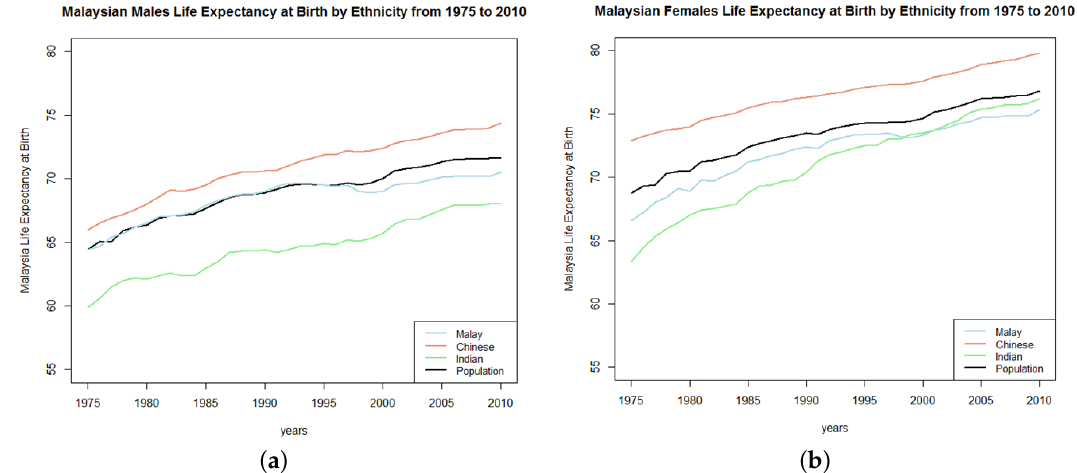
( a ) ( b ) Figure 7. Malaysian observed life expectancy at birth by ethnic groups from 1975 to 2010 for males ( a ) and females ( b ). Table 10. Mean Absolute Forecast Errors ( MAFE ) by ethnic groups and gender in Malaysia. Ethnic-coherence is imposed on coherent models for males and